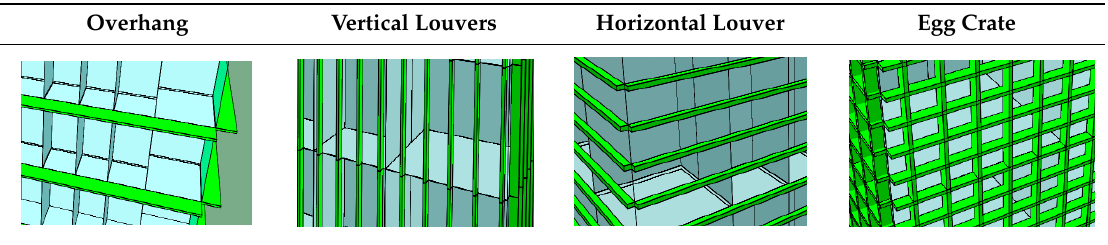
Table 1. External shading simulated.